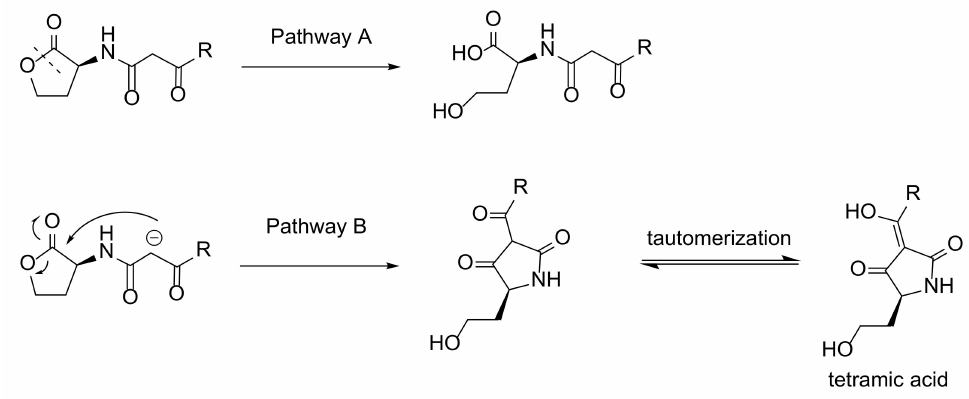
Figure 2. Degradation of 3-oxo-AHLs under basic